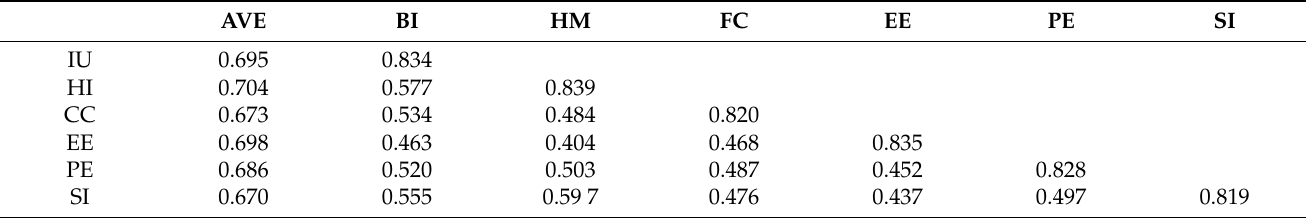
Table 6. Latent variable correlation.